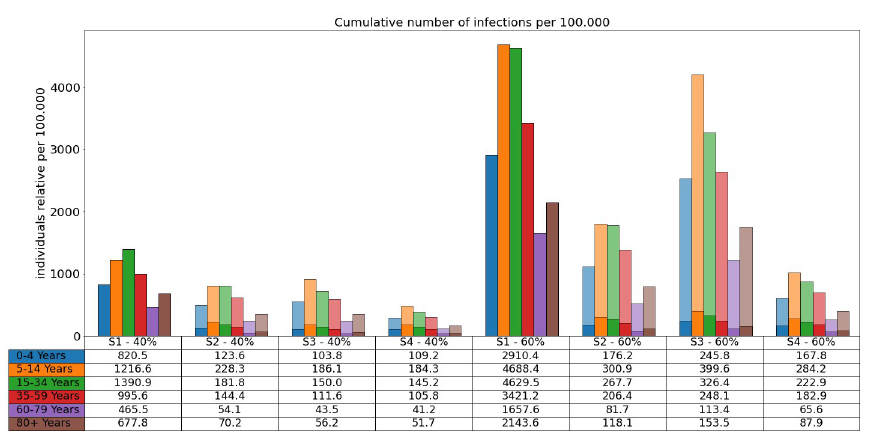
Fig 9. Total number of infections in the different age groups over the duration of the simulation. Bar plots: Number of infections per 100.000 individuals over 90 days and each scenario for Delta 40% (left) and 60% (right). The transparent bars are the 75% percentiles (for the sake of scaling omitted for Scenario 1) and the solid bars are the median values. Table: The median values are also presented in the table below the plot.